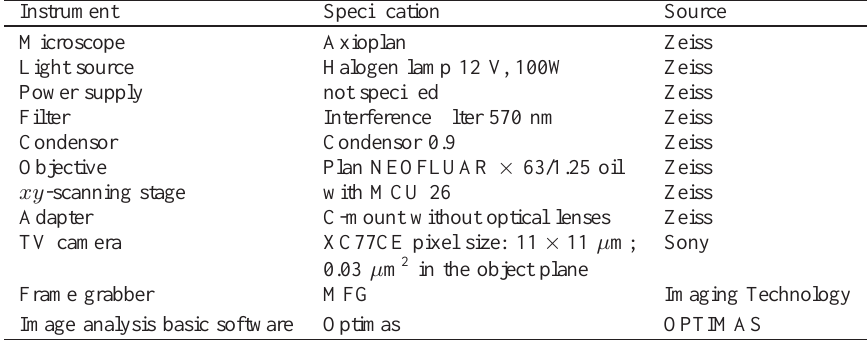
Table 2 Technical equipment for the image cytometry